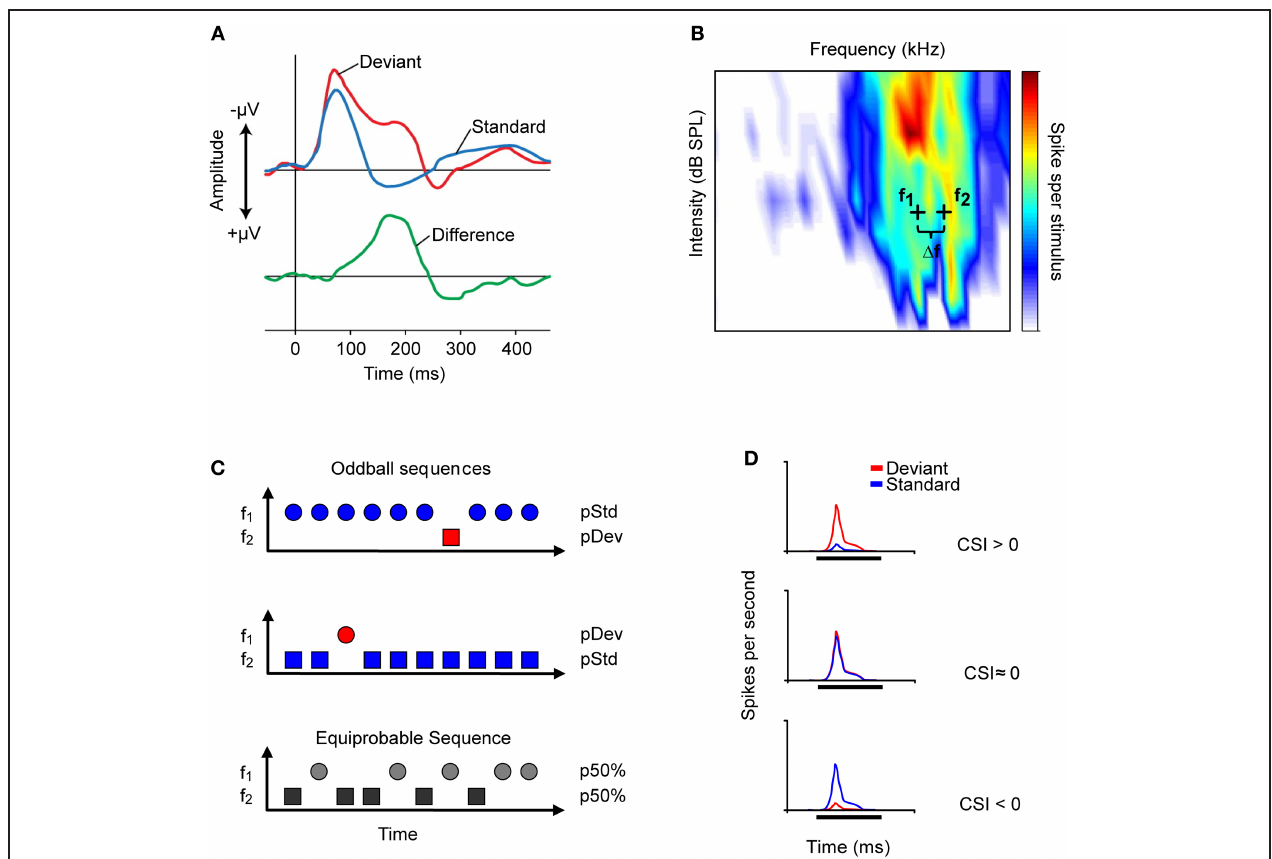
occurring deviant stimulus (red symbol), interspersed randomly among the standards. In a second oddball sequence (middle), the relative probabilities of the two stimuli are reversed, with f 2 as the standard (blue) and f 1 as the deviant (red). As a control (bottom), both frequencies are presented with the same probability of occurrence [equiprobable condition; (cid:3) (cid:2) (cid:3) (cid:2) = p = 50%]. (D) The common-SSA index (CSI) is a widely used f 2 p f 1 metric to quantify the extent of SSA in the neuronal responses. The three PSTHs represents the response to deviant (red) and to standard (blue) tone of neurons exhibiting different values of CSI. The CSI compares the responses to deviant and to standard stimuli from the two oddball sequences by normalizing the responses in terms of spikes per stimulus (see text). The normalization corrects for the different number of presentations of the standard and deviant stimuli in each sequence. The possible values of the CSI range from + 1 to − 1, with positive values indicating that the response magnitude to the deviant is higher than that to the standard stimulus (upper PSTH); zero indicating that the two stimuli elicit equal responses (middle PSTH); and negative values indicating that the response to the standard stimulus is greater than that to the deviant stimulus (bottom